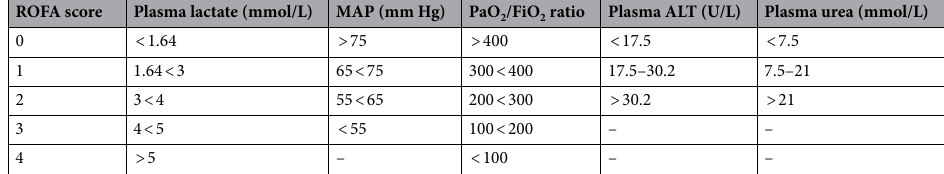
Table 2. Threshold values of the components of rat-specific organ failure assessment (ROFA) scoring system. Sepsis was defined as cumulative ROFA score above 2. MAP mean arterial pressure, ALT alanine